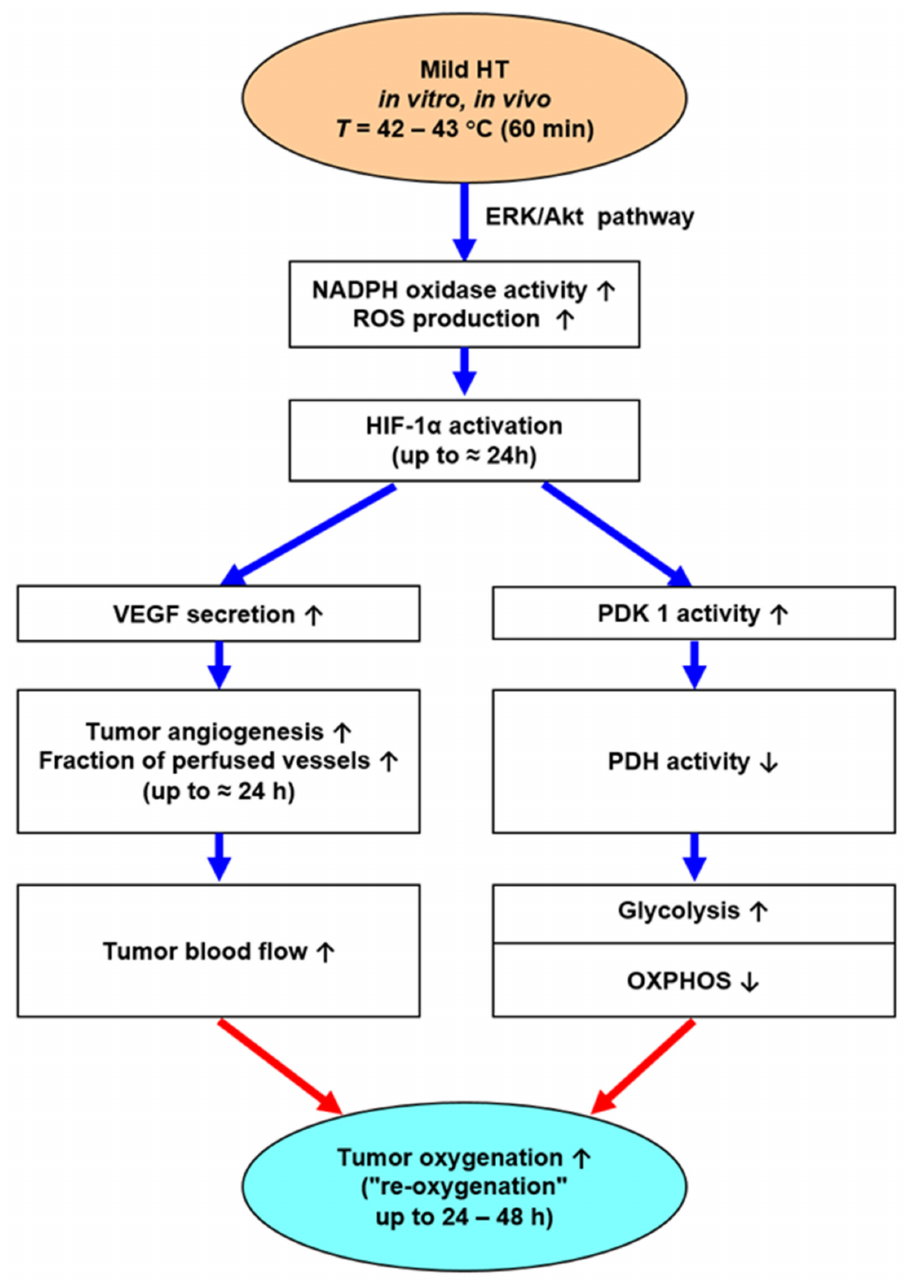
Figure 5. Heat-sensitive ERK/Akt-pathways (central pathway), metabolic reprogramming (right pathway), and VEGF-triggered robust angiogenesis (left pathway) and their putative role in sustained (up to 24–48 h) improvement of the tumor oxygenation